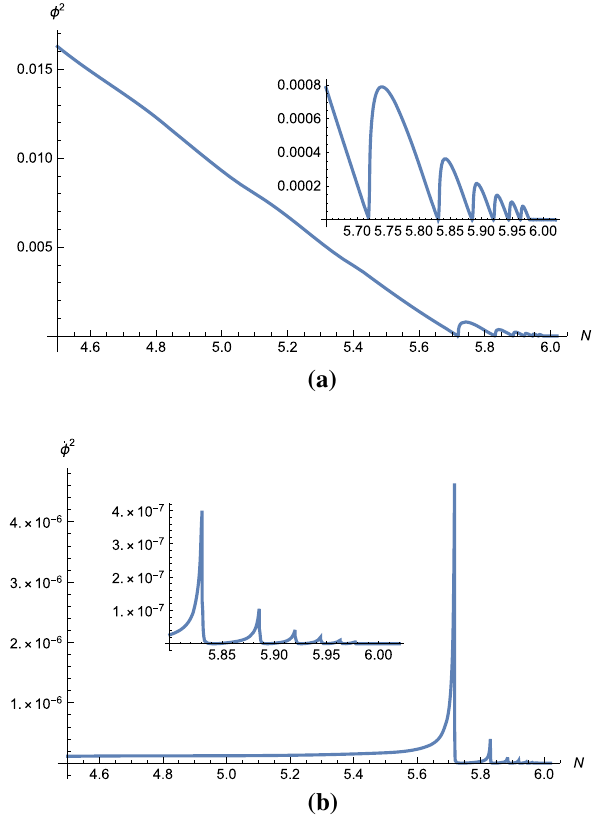
Fig. 8 The typical behavior of φ 2 and ˙ φ 2 . One has to note that before the onset of the oscillations, ˙ φ is approximately constant which implies ¨ φ ≈ 0. This is in complete accord with slow-roll approximation. ˙ φ increases rather gradually when φ reaches the minimum but it decreases more abruptly as φ leaves the minimum towards the return point. This phenomena stems from the dissipative characteristic of the oscillations and results in decaying amplitude